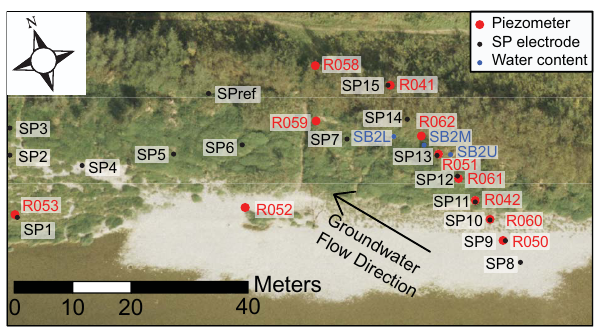
Fig. 3. SP monitoring area with SP monitoring (SP1-15) and refer- ence (SPref) electrodes, piezometers, and soil monitoring stations. The tower on which rainfall intensity was measured is located ap- proximately 100m away from this